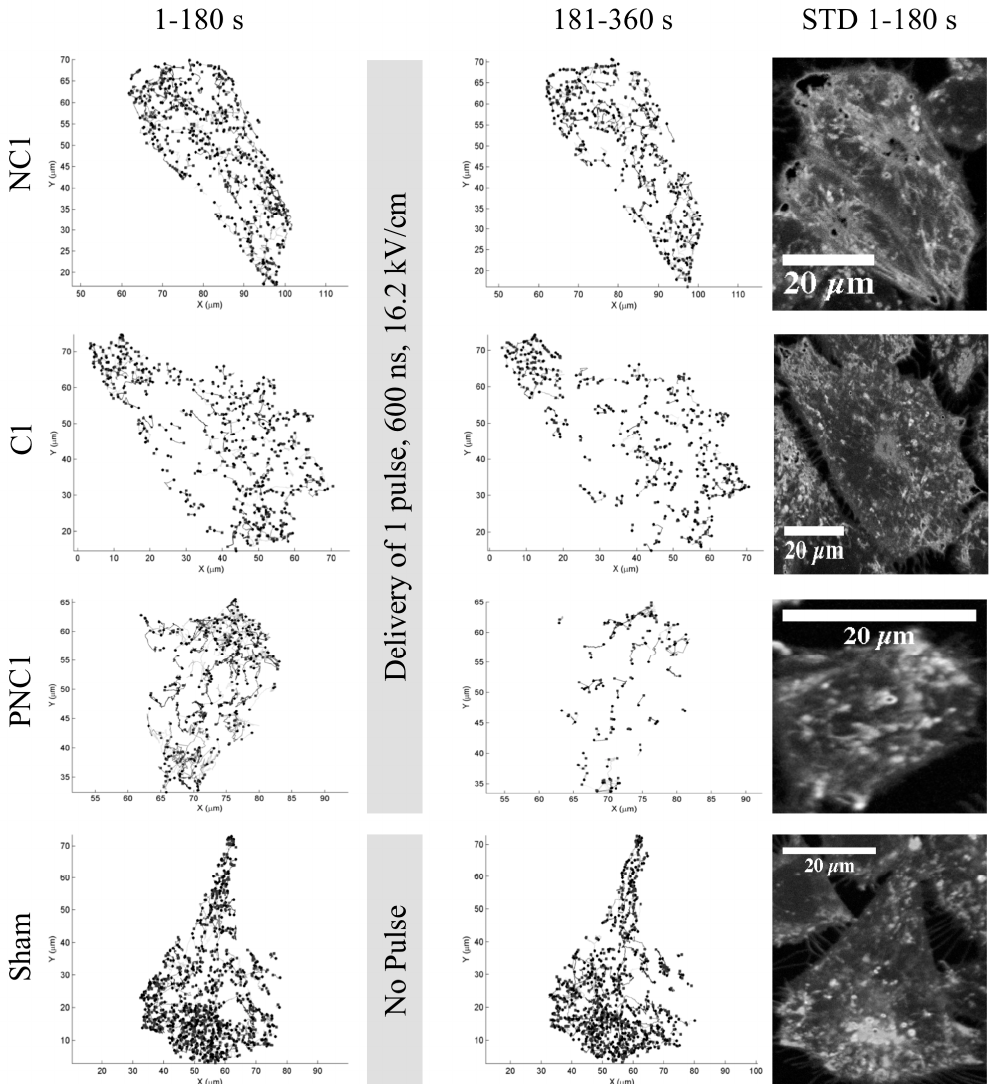
Figure 1. Tracks of lysosome movement show decreased numbers and lengths of lysosome trajectories for cells before ( left ) and after ( right ) exposure to a single, 600-ns pulsed electric field (PEF) at 16.2 kV/cm in solutions without external Ca 2+ (NC1), with external Ca 2+ (C1), or with PEG and without Ca 2+ (PNC1). A sham exposure (i.e., a nanosecond PEF (nsPEF) was not delivered) in PNC is represented on the bottom. The standard deviation of a stack of representative confocal fluorescence images of the cells are shown on the far right.